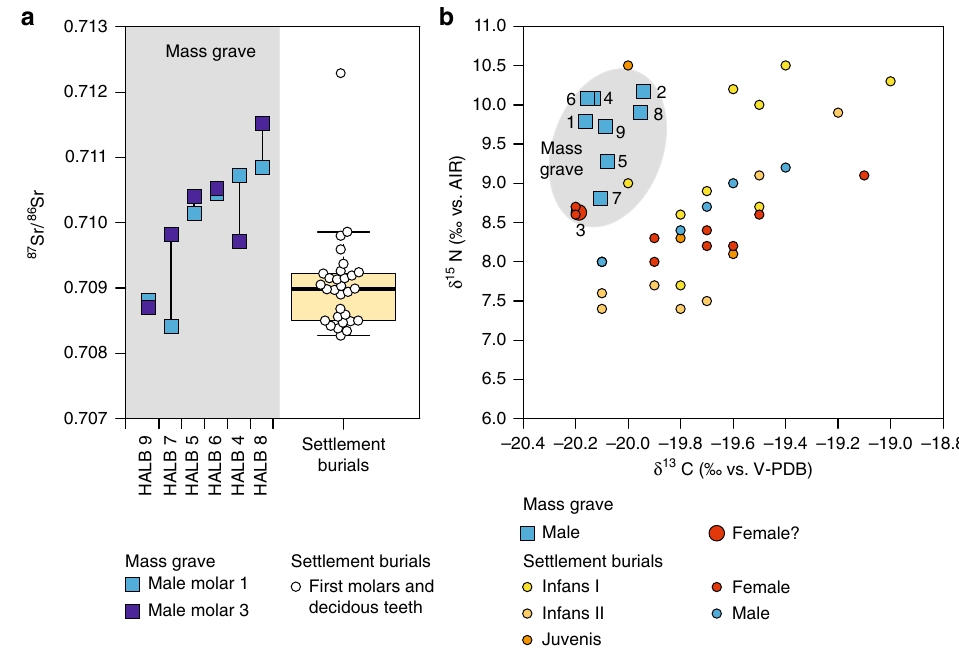
Fig. 7 Results of the strontium, carbon and nitrogen isotope analyses. Strontium isotope ratios of enamel ( a ) and carbon and nitrogen isotope data of bone collagen ( b ) of the individuals from the mass grave in comparison to data from regular LBK and likely LBK settlement burials at Halberstadt. Both analytical methods show the mass grave individuals to be different from the regular interments implying both non-local origins and distinct dietary habits. Individuals subsequently identi fi ed as non-LBK have been removed from the settlement burial dataset published previously